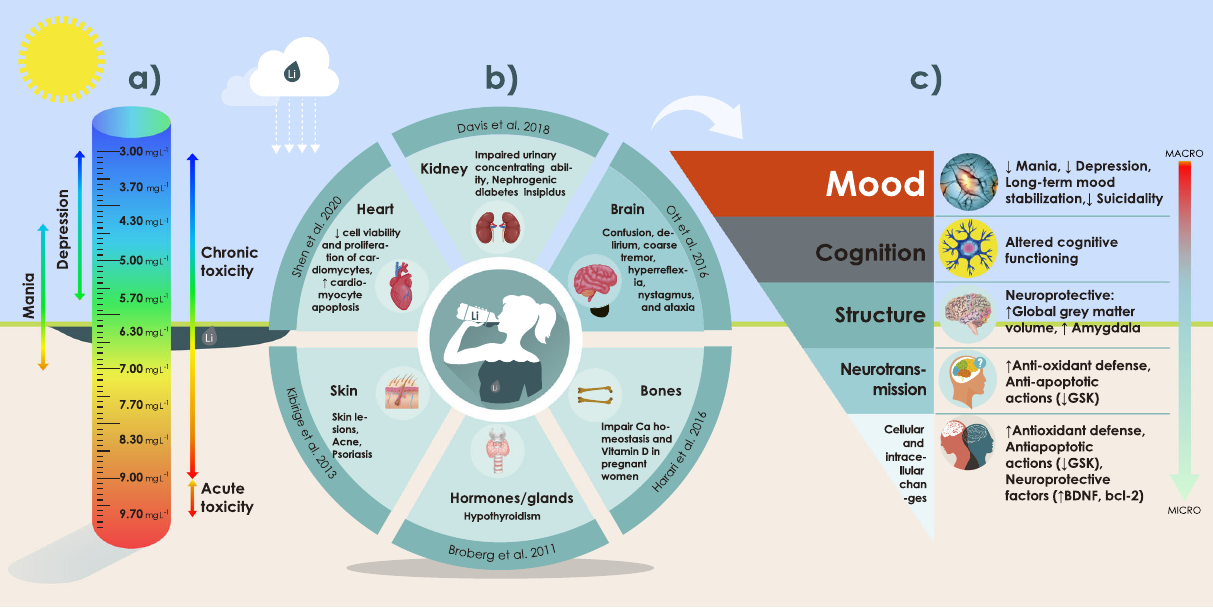
Fig. 5 Figure highlights the impact of lithium on human body organs that comes through drinking water. Illustration of ( a ) Lithiumeter depicting the acute and chronic toxicity categories for various Li concentration ranges in the human body ( b ) Drinking water containing Li and associated consequences on human body organs, and ( c ) Impact of Li on functions linked with the human brain arrow highlight that Li impact on macro organs to micro organs of the human body. “ ↑ ” highlights the increase and “ ↓ ” show the decrease of disease